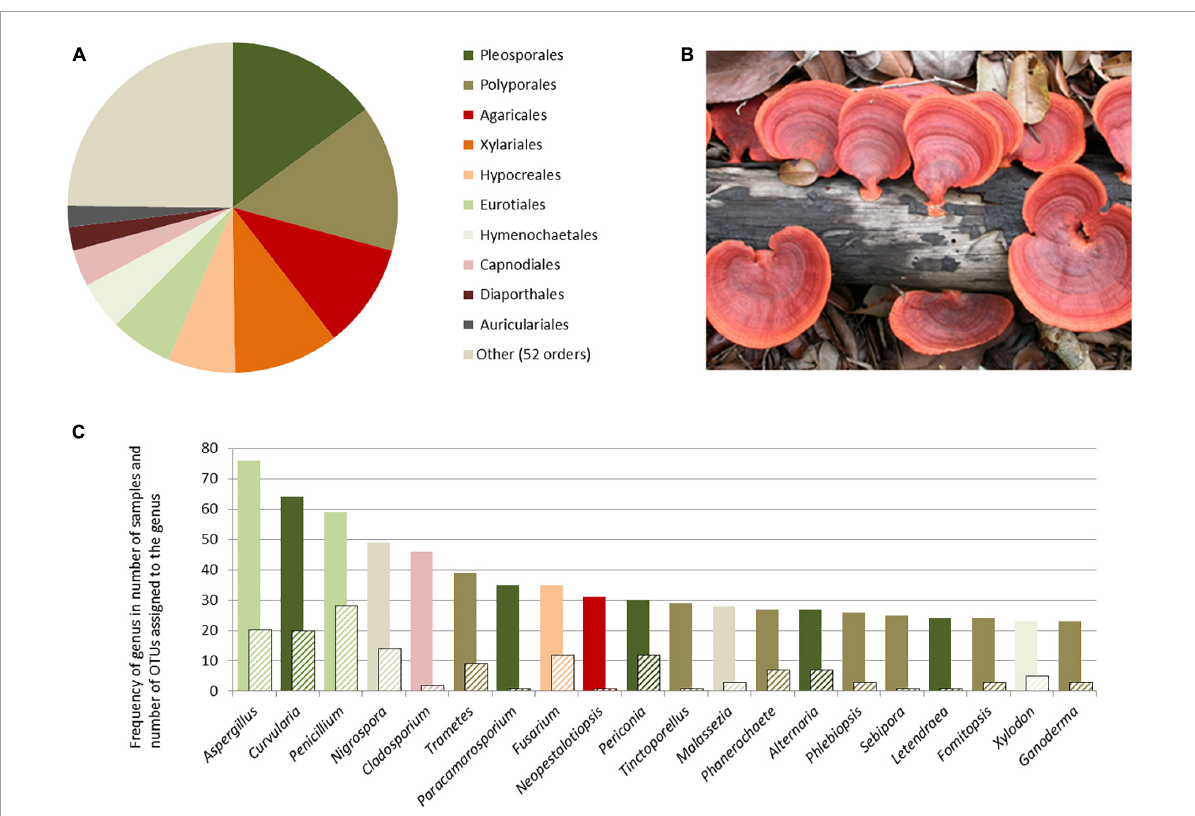
FIGURE2 Overview of the taxonomic identification of fungal sequences extracted from air samples taken in Reserva Biológica do Uatumã, Central Amazonia, based on ITS2 target region. (A) Number of OTUs identified per fungi order; (B) Pycnoporus sanguineus (= Trametes sanguinea in NCBI) on a decaying log in Central Amazonia, a representative of one of the most frequently captured fungi genera; (C) frequency of genera in terms of number of samples (colored bars) and number of OTUs assigned to each genus (hatched bars)—column color refers to the order they belong, following (A)